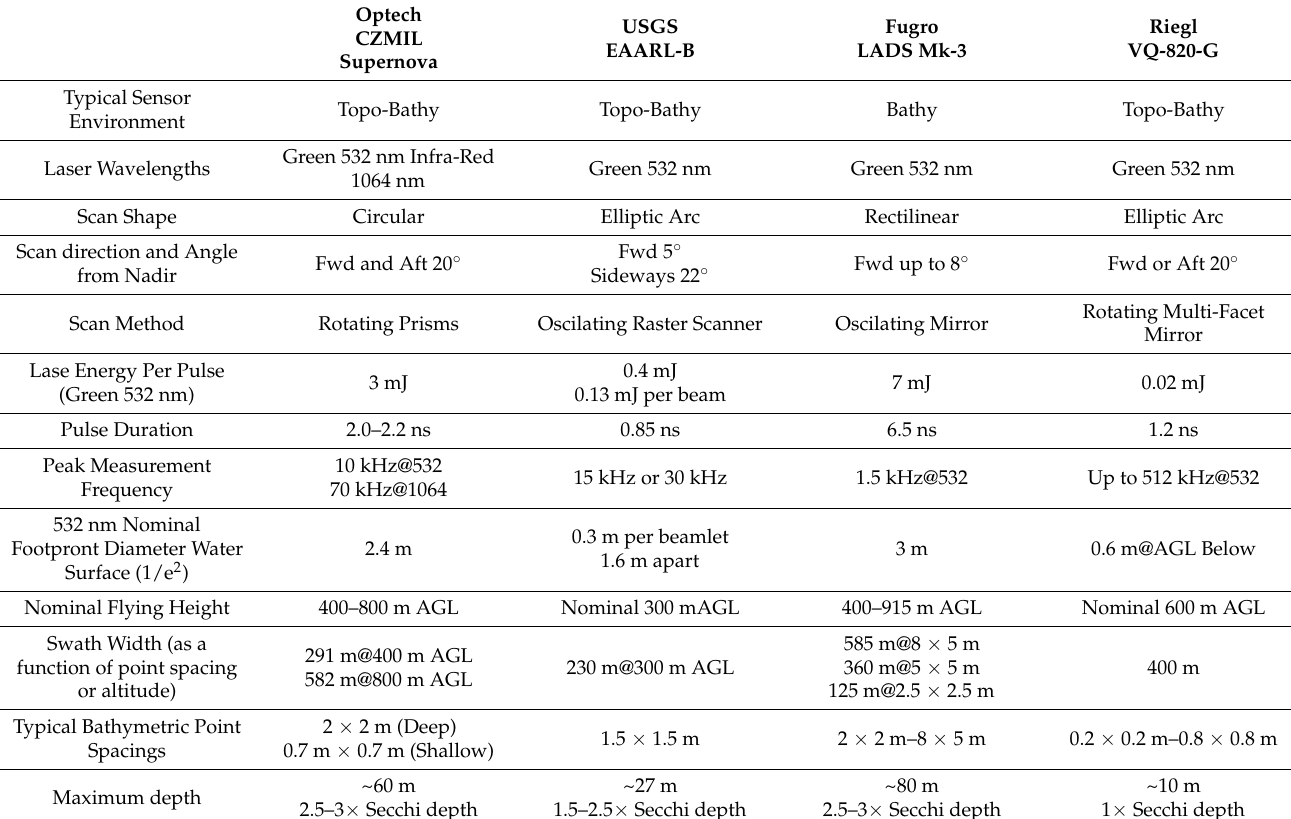
Table 3. Specification of selected ALB sensors taking measurements from the